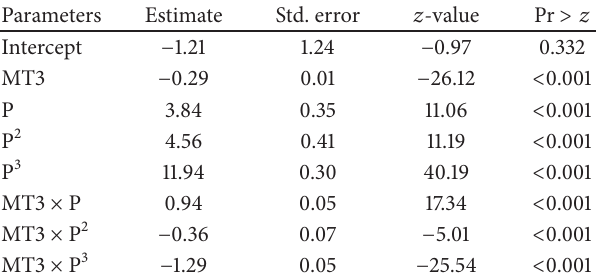
Table 6: Parameter estimates for the most supported model exploring effects of temperature and precipitation on the breeding migration pattern of L. vulgaris